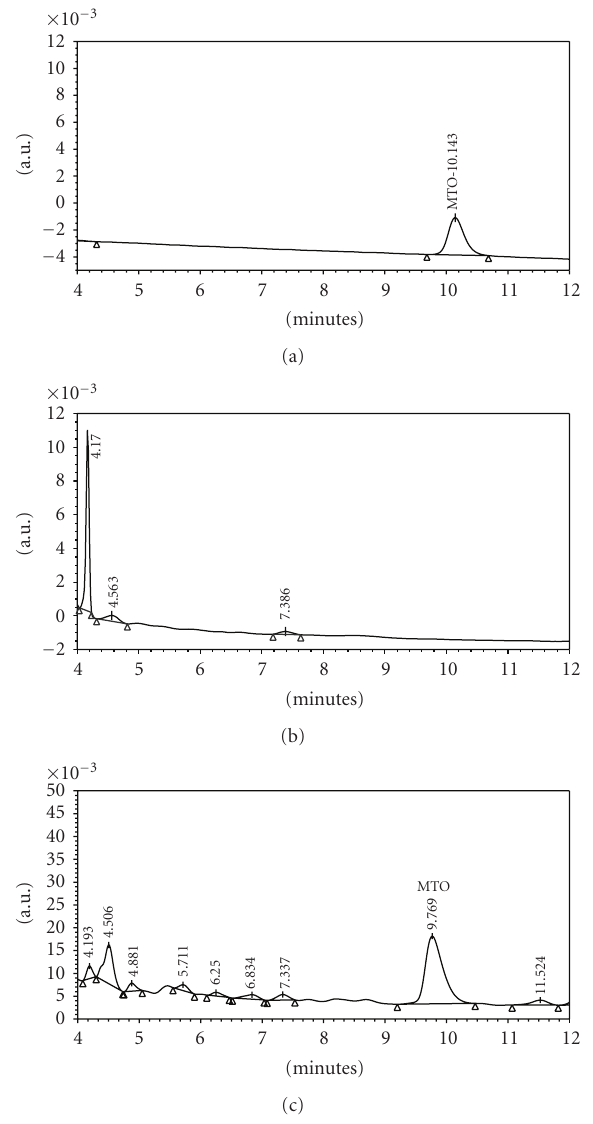
Figure 4: (a) HPLC-chromatogram of pure mitoxantrone (MTO 200ng/mL), (b) HPLC-chromatogram of processed blank liver tissue . No interfering peak at the retention time is determined for MTO. Chromatographic Conditions: 3 . 0 × 100 mm X-Bridge Phenyl column (Waters, Germany), flow: 1 mL/min, mobile phase: bu ff er (80nM sodium formate and formic acid, pH 3.0) and methanol (80:20v/v). Column temperature 55 ◦ C, injection volume 50 μ L, UV-detection: 254 nm. (c) HPLC-chromatogram of processed liver tissue containing MTO bound to ferrofluids. MTO is at retention time 9,77.